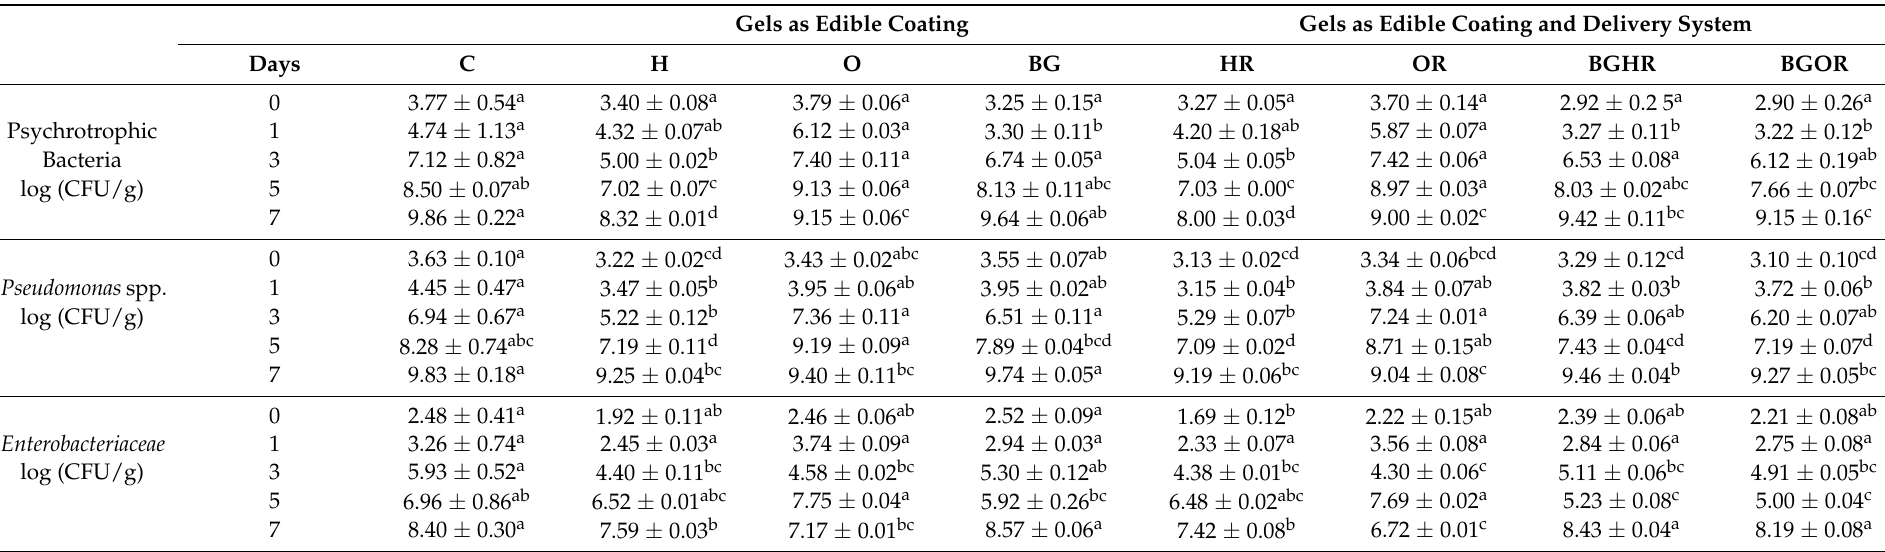
Table 1. Microbiological characteristics of sardine fillets coated with or without RE during storage at 4 ◦ C. Gels as Edible Coating Gels as Edible Coating and Delivery